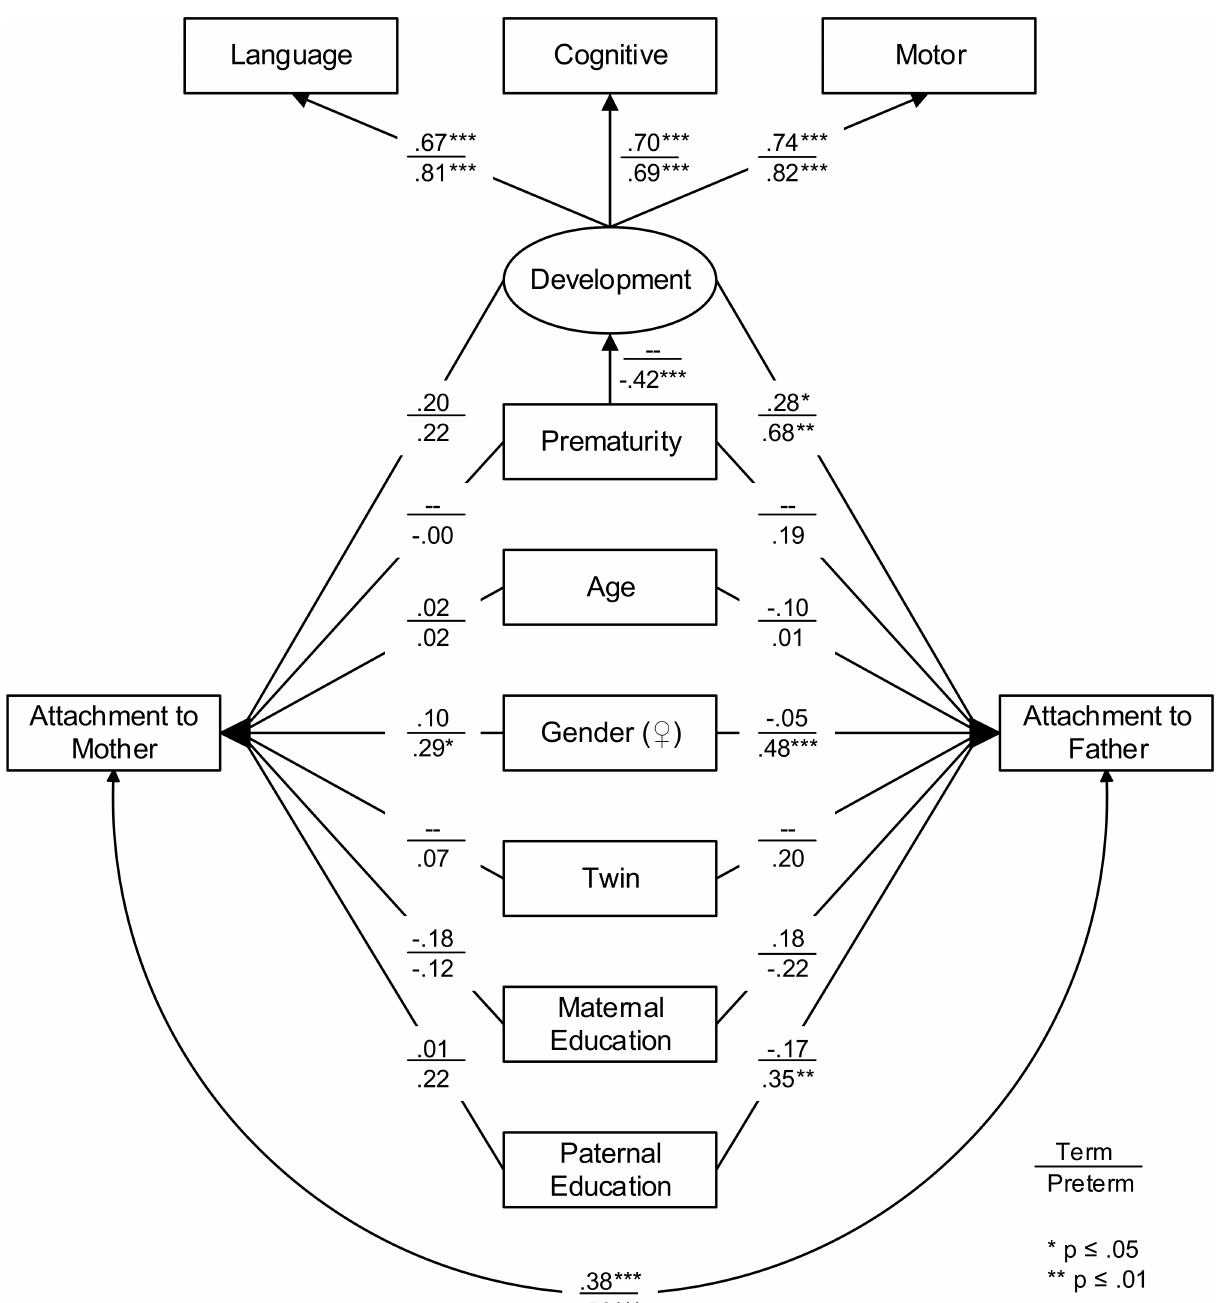
Fig 2. Multigroup base model of mother-child and father-child attachment in preterm and term children. Note: the weights of the BSID-III differ only due to standardization.